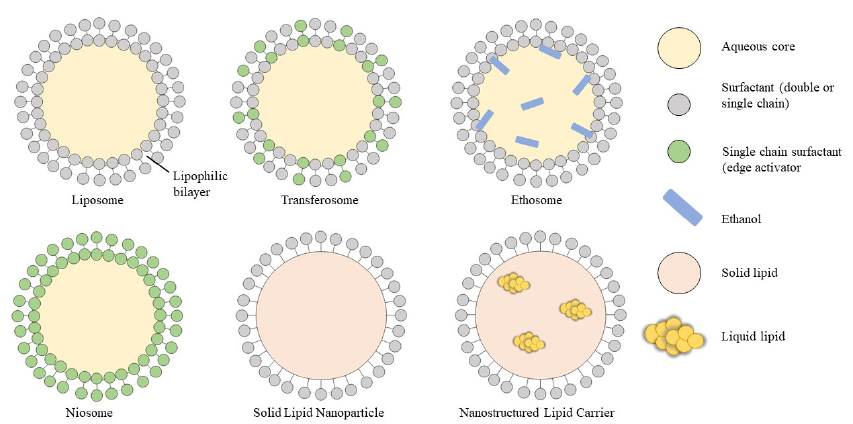
Figure 7. A depiction of nanocarriers used to carry ATRA for the management of different dis- eases.